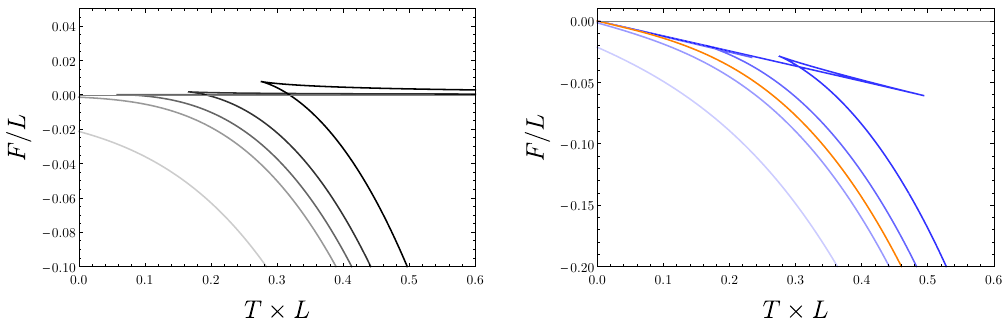
Figure 10 . Free energy vs. temperature in four dimensions using shifted entropy . Here we plot the free energy vs. temperature for Φ = 0 , 1 . 6 , 1 . 957 , 2 . 2 , 3 (more to less opacity) for Einstein gravity 4 (right). In this plot, the entropy has been shifted by = 10 (left) and the cubic theory with µ/µ − c + 2 π √ 6 µ which ensures that the entropy is always positive. The orange the constant S = S Wald − curve on the right corresponds to Φ = 1 . 957, which results in a critical